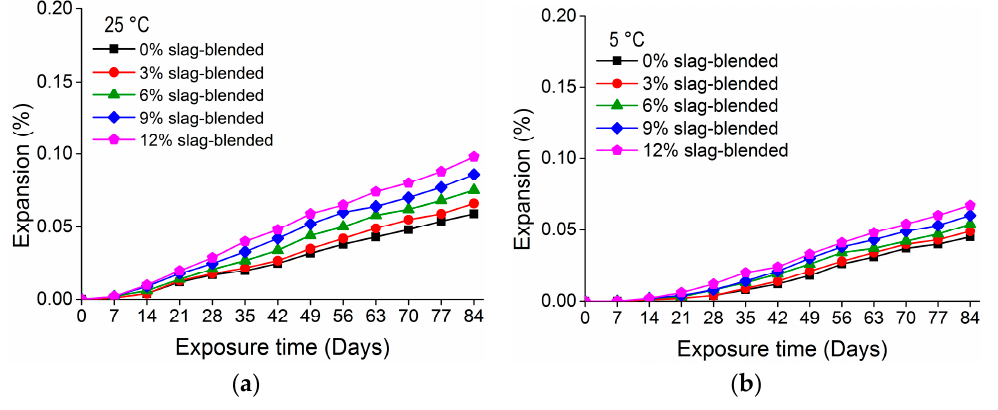
Figure 6. Expansion in nano-TiO 2 containing slag-blended mortars immersed in 10% Na 2 SO 4 solution at ( a ) 25 °C ( b ) 5 °C.